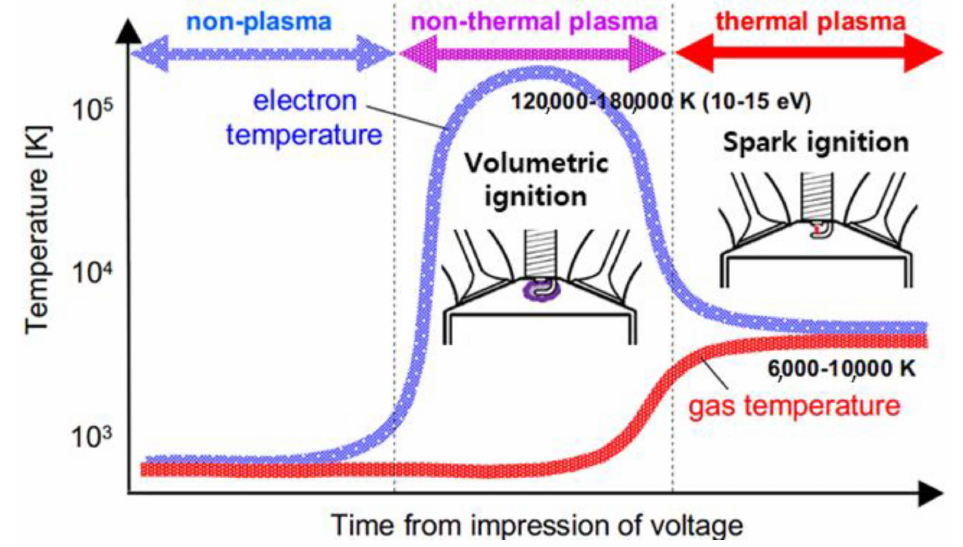
Figure 2. Classification of thermal and non-thermal plasma according to temperature regimes (figure modified from